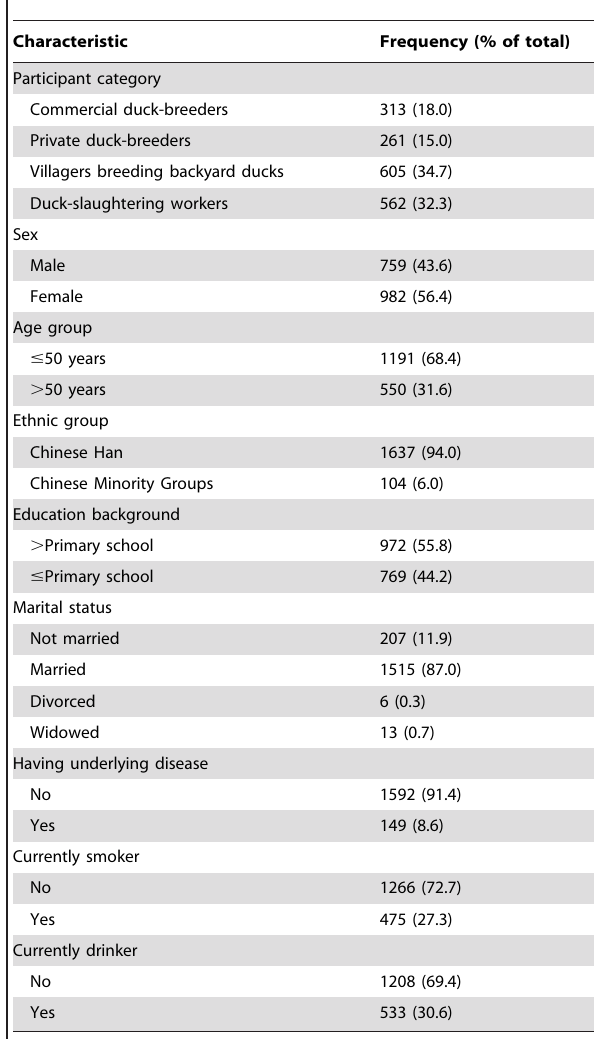
Table 1. Baseline characteristics of study participants